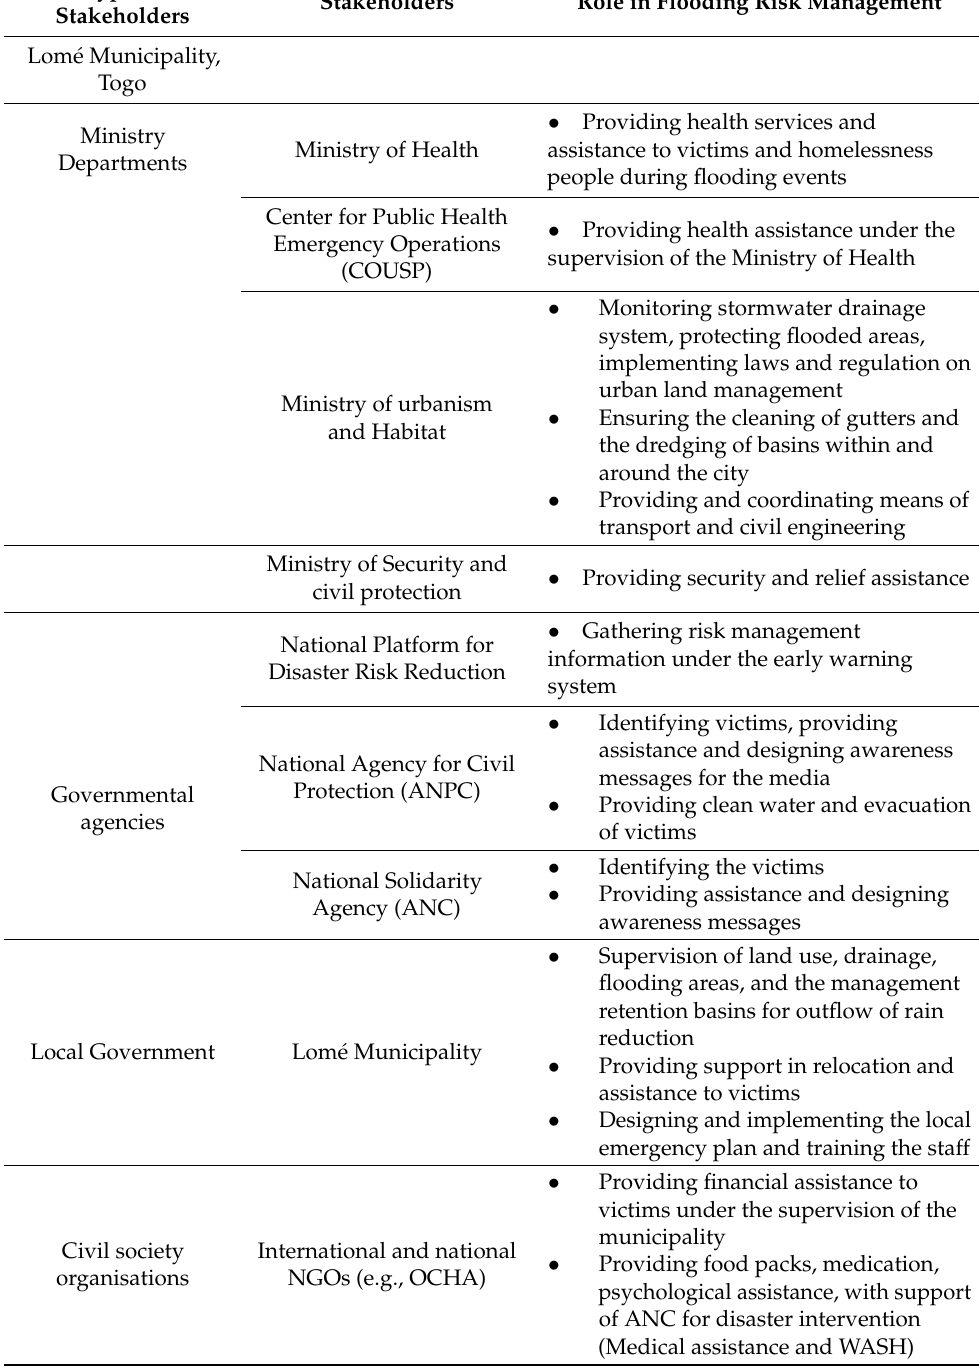
Table 2. Stakeholders and implication in flooding risk management in Lom é